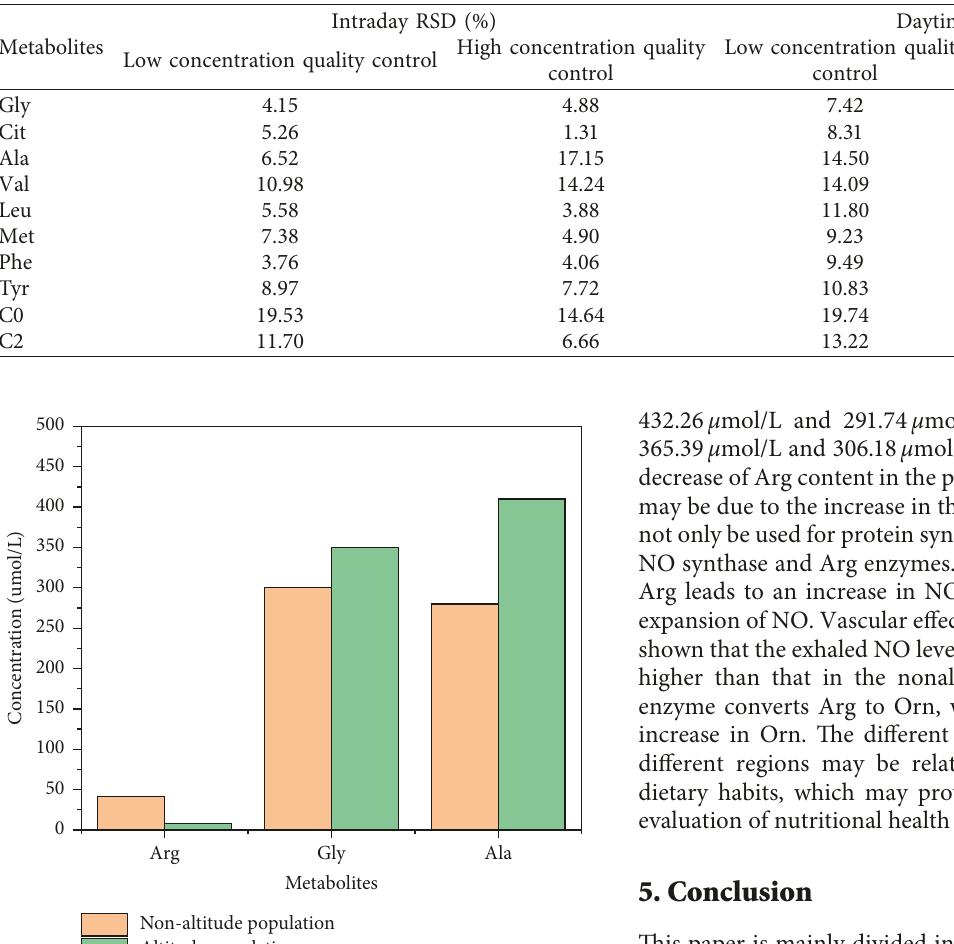
Table 2: Within-day ( n � 3) and between-day precision ( n � 18) of metabolites in quality control.